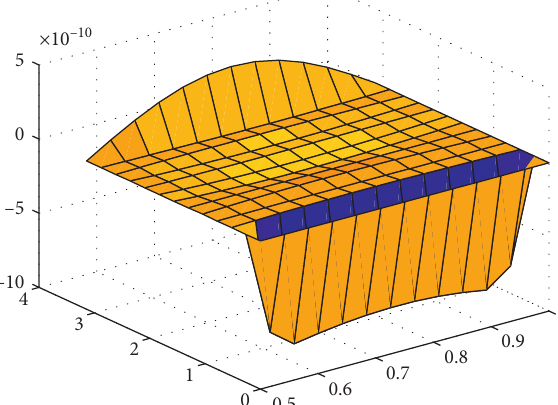
Figure 1: Errors of LBRCM by equidistant nodes with m � n � 12and d